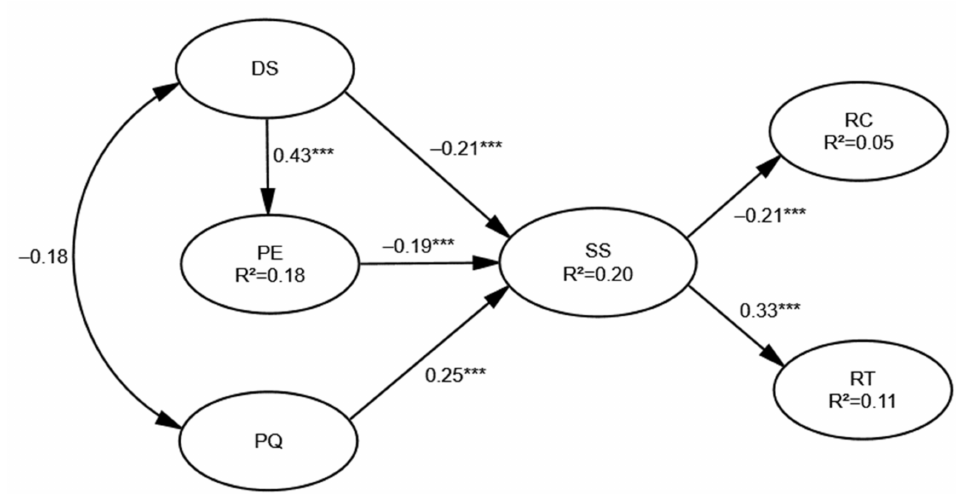
Figure 3. Path estimates of the model (*** p <